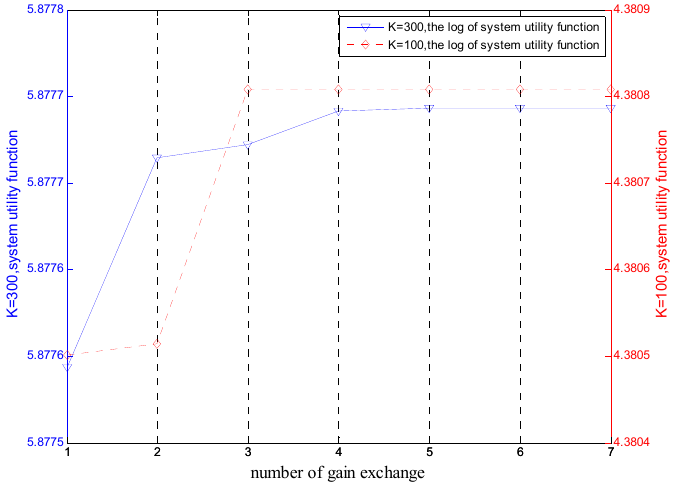
Figure 2. Variation curves of system utility functions at K 1 = 100 and K 2 =